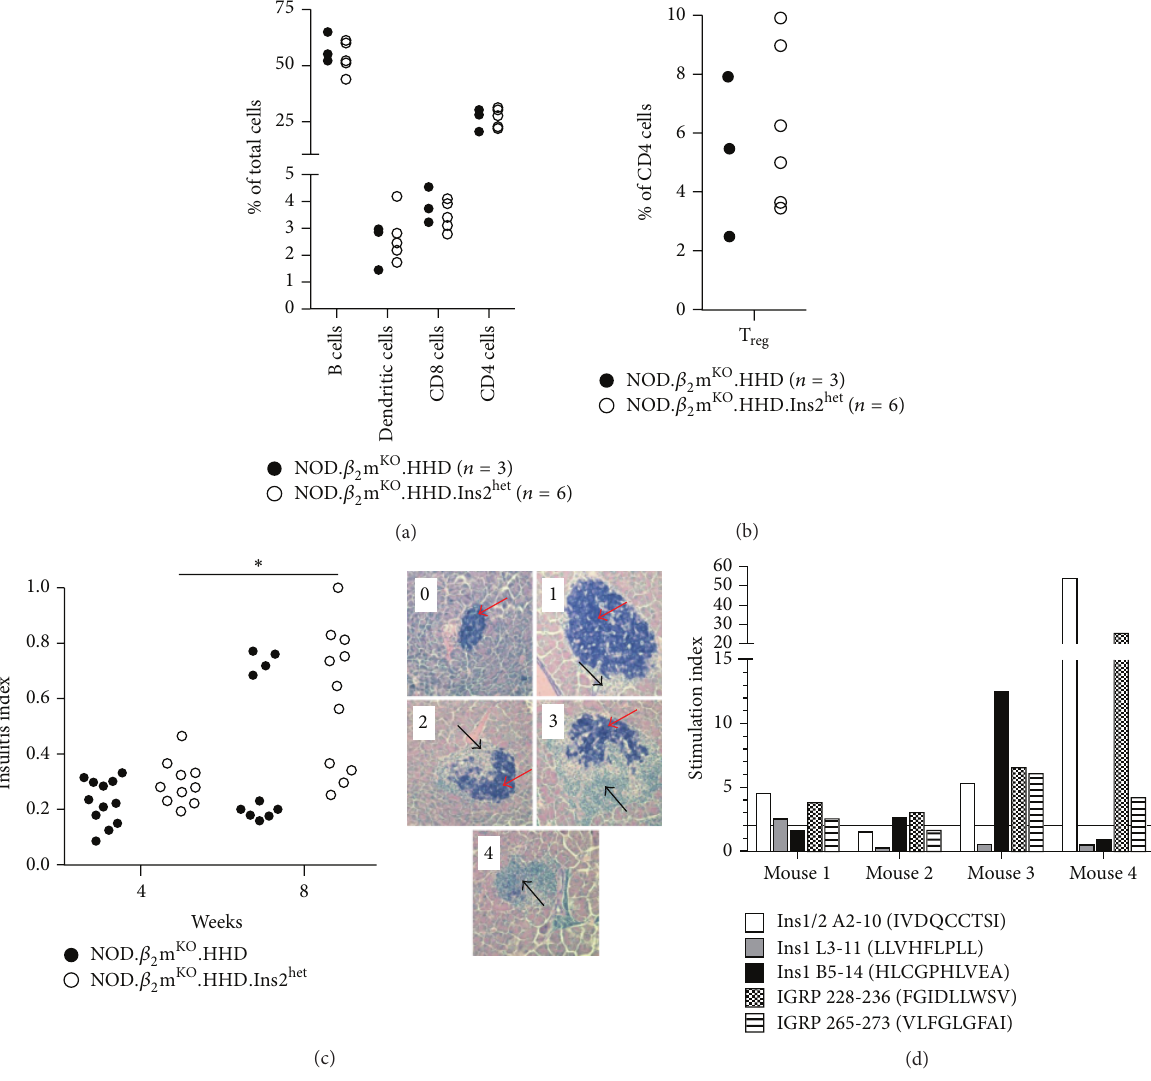
Figure 3: Splenocyte composition, insulitis, and autoreactive CD8 T cell specificities in NOD. 𝛽 2 m KO .HHD.Ins 2 het mice. (a) and (b) Splenocytes from 8-week-old female NOD. 𝛽 2 m KO .HHD (filled circles) and NOD. 𝛽 2 m KO .HHD.Ins 2 het mice (open circles) were analyzed by flow cytometry. Each symbol represents an individual mouse. (c) Female NOD. 𝛽 2 m KO .HHD (filled circles) and NOD. 𝛽 2 m KO .HHD.Ins 2 het mice (open circles) were sacrificed at 4 and 8 weeks of age and insulitis indices were determined as described in Materials and Methods and plotted. Each symbol represents an individual mouse. ∗ 𝑝 = 0.0037 (Mann-Whitney 𝑈 ). Representative islets from a single NOD. 𝛽 2 m KO .HHD.Ins 2 het mouse are also shown. In these images, beta cells appear dark purple and are denoted by red arrows, while the more lightly stained infiltrating immune cells are marked by black arrows. The number on each image indicates the insulitis score of the islet shown. (d) Islet-infiltrating cells from 8-week-old female NOD. 𝛽 2 m KO .HHD.Ins 2 het mice were tested for reactivity to the indicated HLA- A ∗ 02:01-restricted insulin and IGRP epitopes by IFN- 𝛾 ELISPOT. Stimulation index was calculated by dividing the number of spots detected foragivenpeptidebythenumberofspotsdetectedwithanirrelevantHIV-derivedHLA-A ∗ 02:01-bindingpeptide.Astimulationindexgreater than 2 was considered a positive